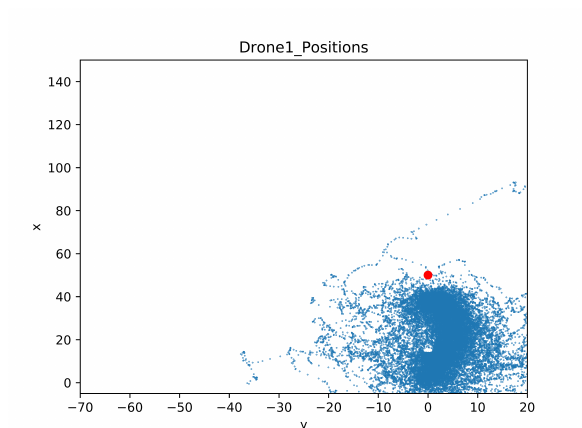
Figure 28. Drone Position Map for Case 1.1.